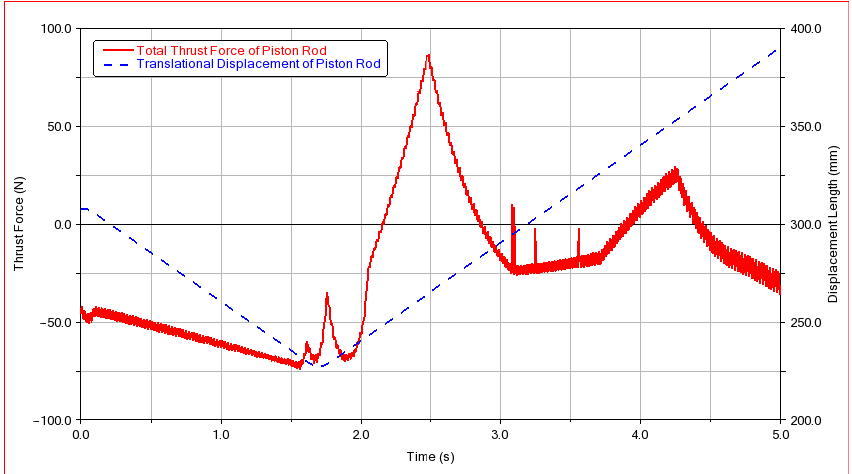
Figure 10. Simulation characteristic curves: the blue dotted curve reflects the transitional displace ‐ ment of the piston rod; the red curve reflects the total thrust force of the piston rod.